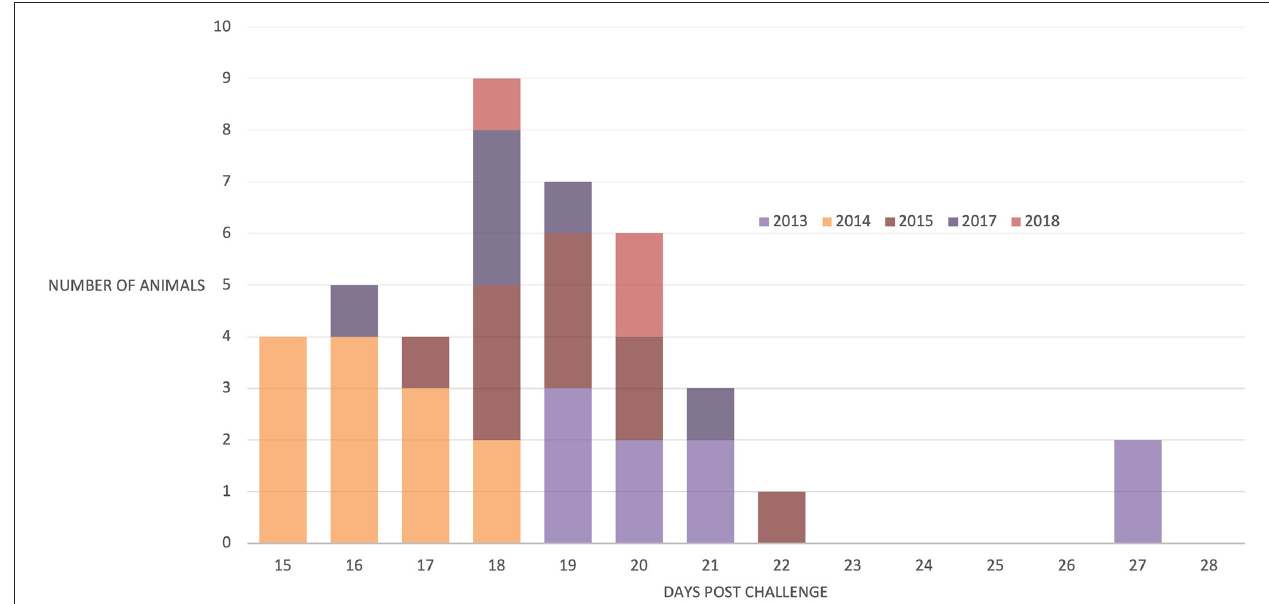
FIGURE 2 | Number of animals that succumbed to disease post-natural challenge in all five trials. N = 9 (2013), 13 (2014), 10 (2015), 6 (2017), and 4 (2018).